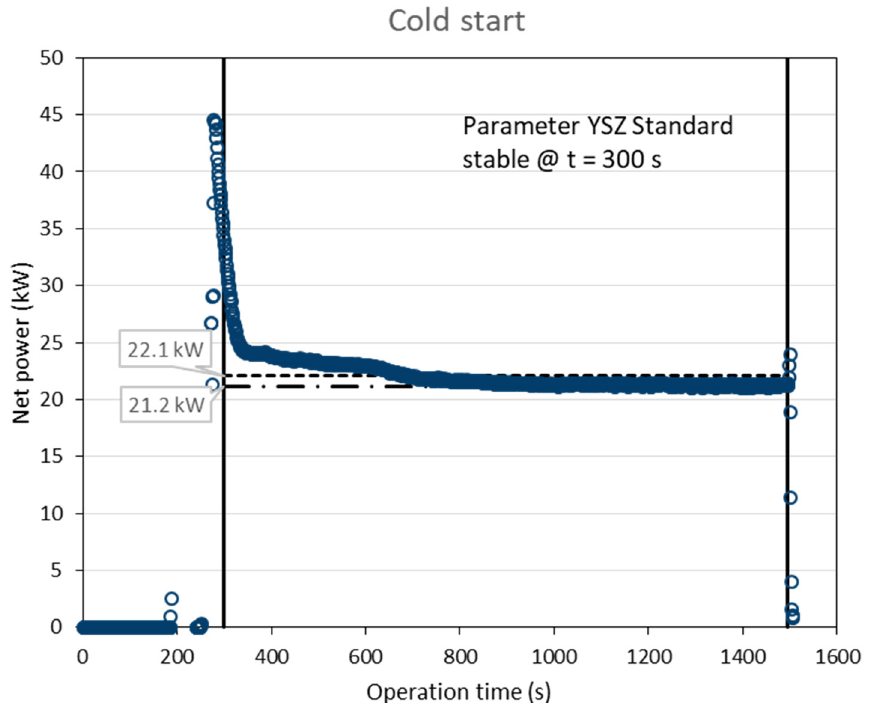
Figure 3. Time course of the torch net power calculated from the torch input power and the power dissipated to the water cooling (cold start of the gun); stable plasma conditions were indicated by the controller at t = 300 s.